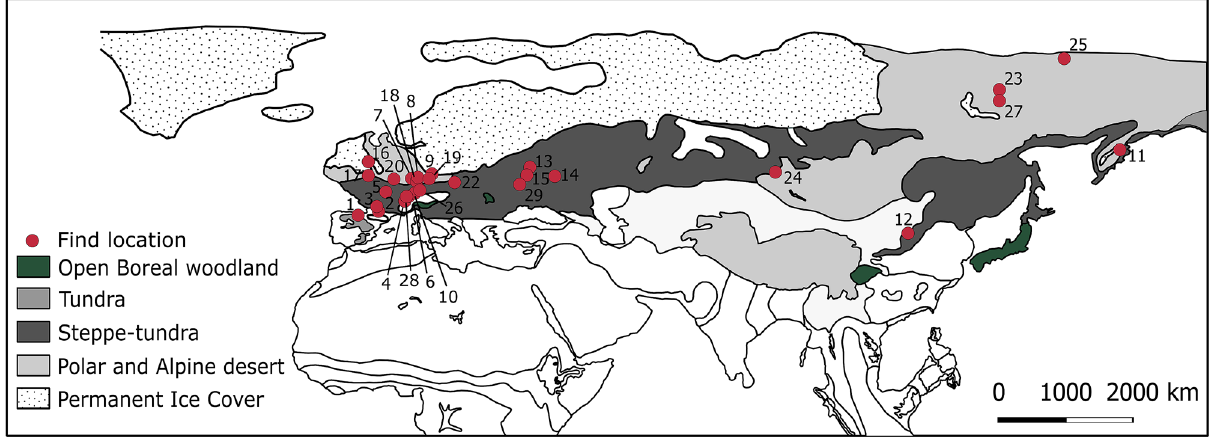
Figure 1. A map of vegetation zones during the Last Glacial Maximum 40 and Palaeolithic dog remain discoveries (see